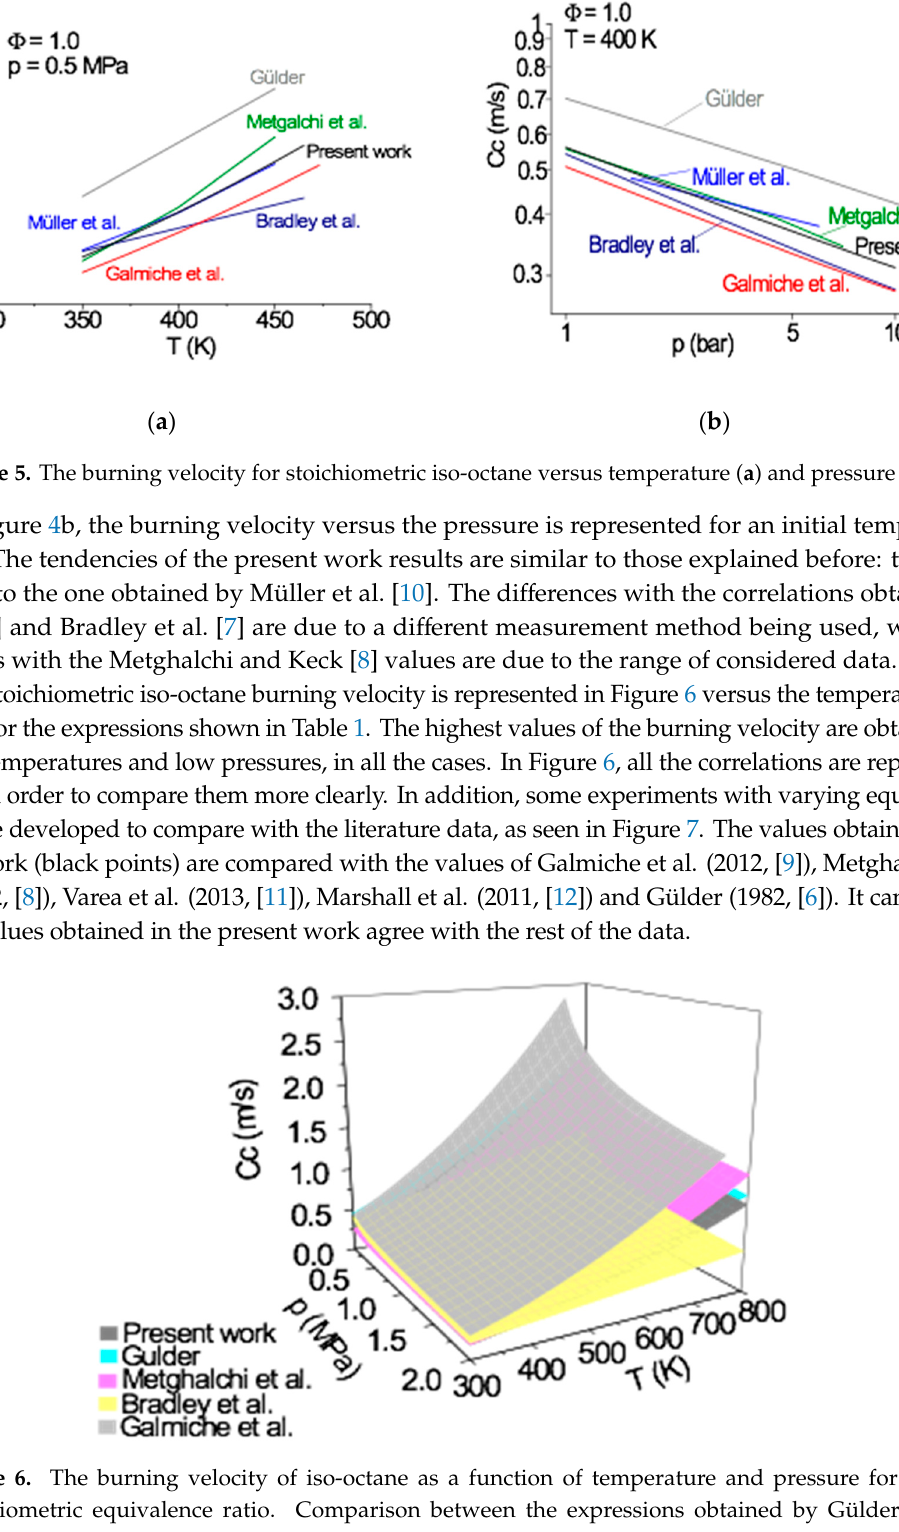
Figure 7. Comparison of the burning velocity of iso-octane versus the equivalence ratio, for 0.8 MPa and 400 K of the initial conditions. 3.2. Burning Velocity of n-Heptane In this section, the results for the burning velocity of n-heptane/air mixtures in the CVCB are presented for the different initial conditions of the pressure and temperature. The initial conditions are chosen to be able to reach the range of pressure and temperature obtained by the internal combustion in engines during the progress of the combustion, as can be seen in Figure 8a. The objective of these experiments is to characterize the burning velocity of n-heptane through correlations as a function of pressure and temperature and the fuel/air equivalence ratio, Equation (2).